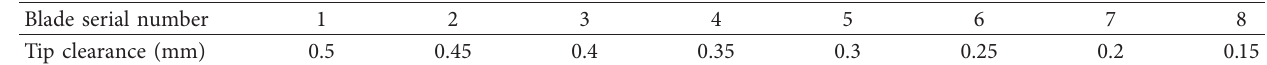
Figure 1: Finite element model of bladed disk structure. Table 1: Static state tip clearance of each blade.